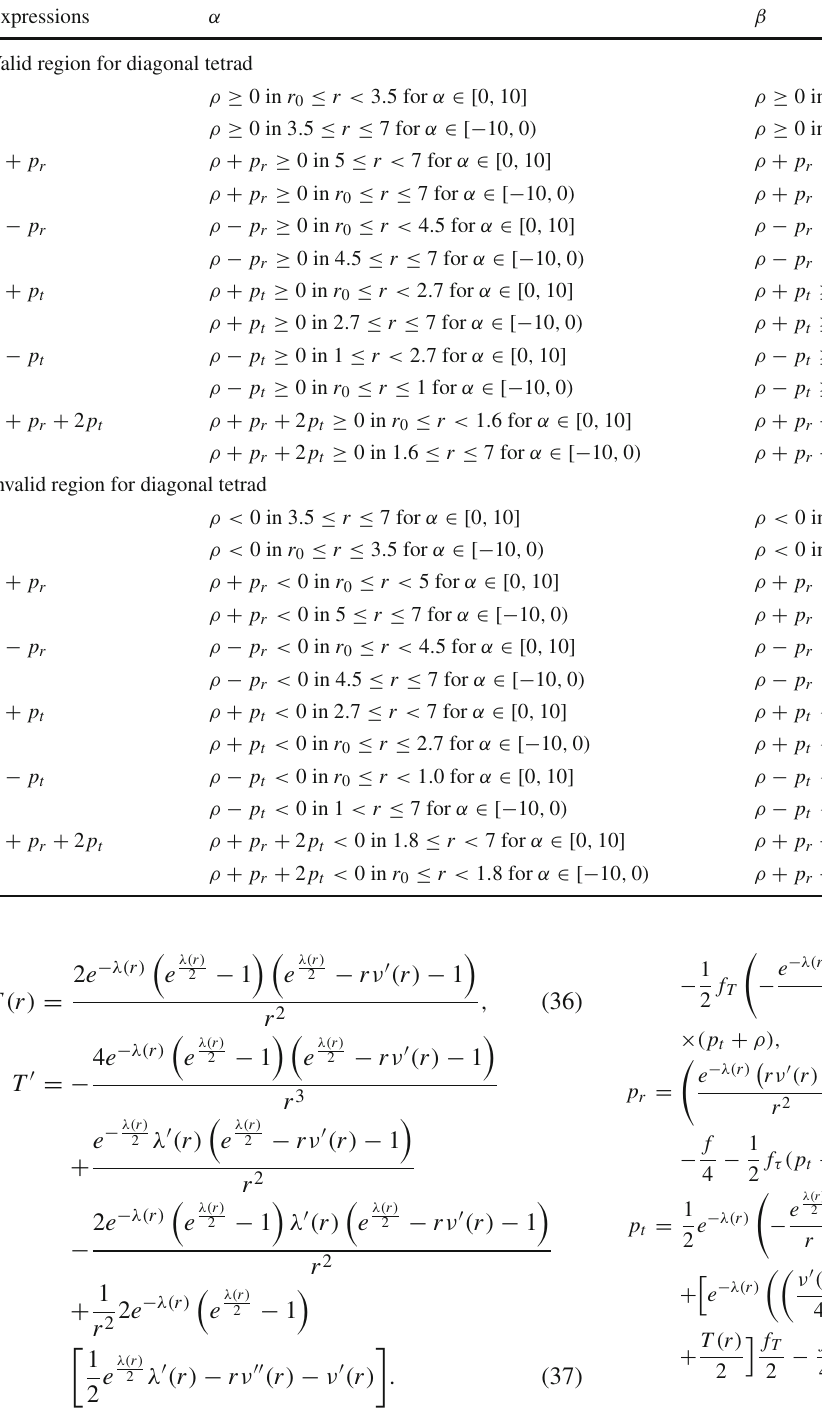
Table 1 Summery of energy conditions in extended teleparallel gravity with diagonal tetrad Expressions α β Valid region for diagonal tetrad ≤ r < 3 . 5 for α ∈ [ 0 , 10 ρ ρ ≥ 0 in r 0